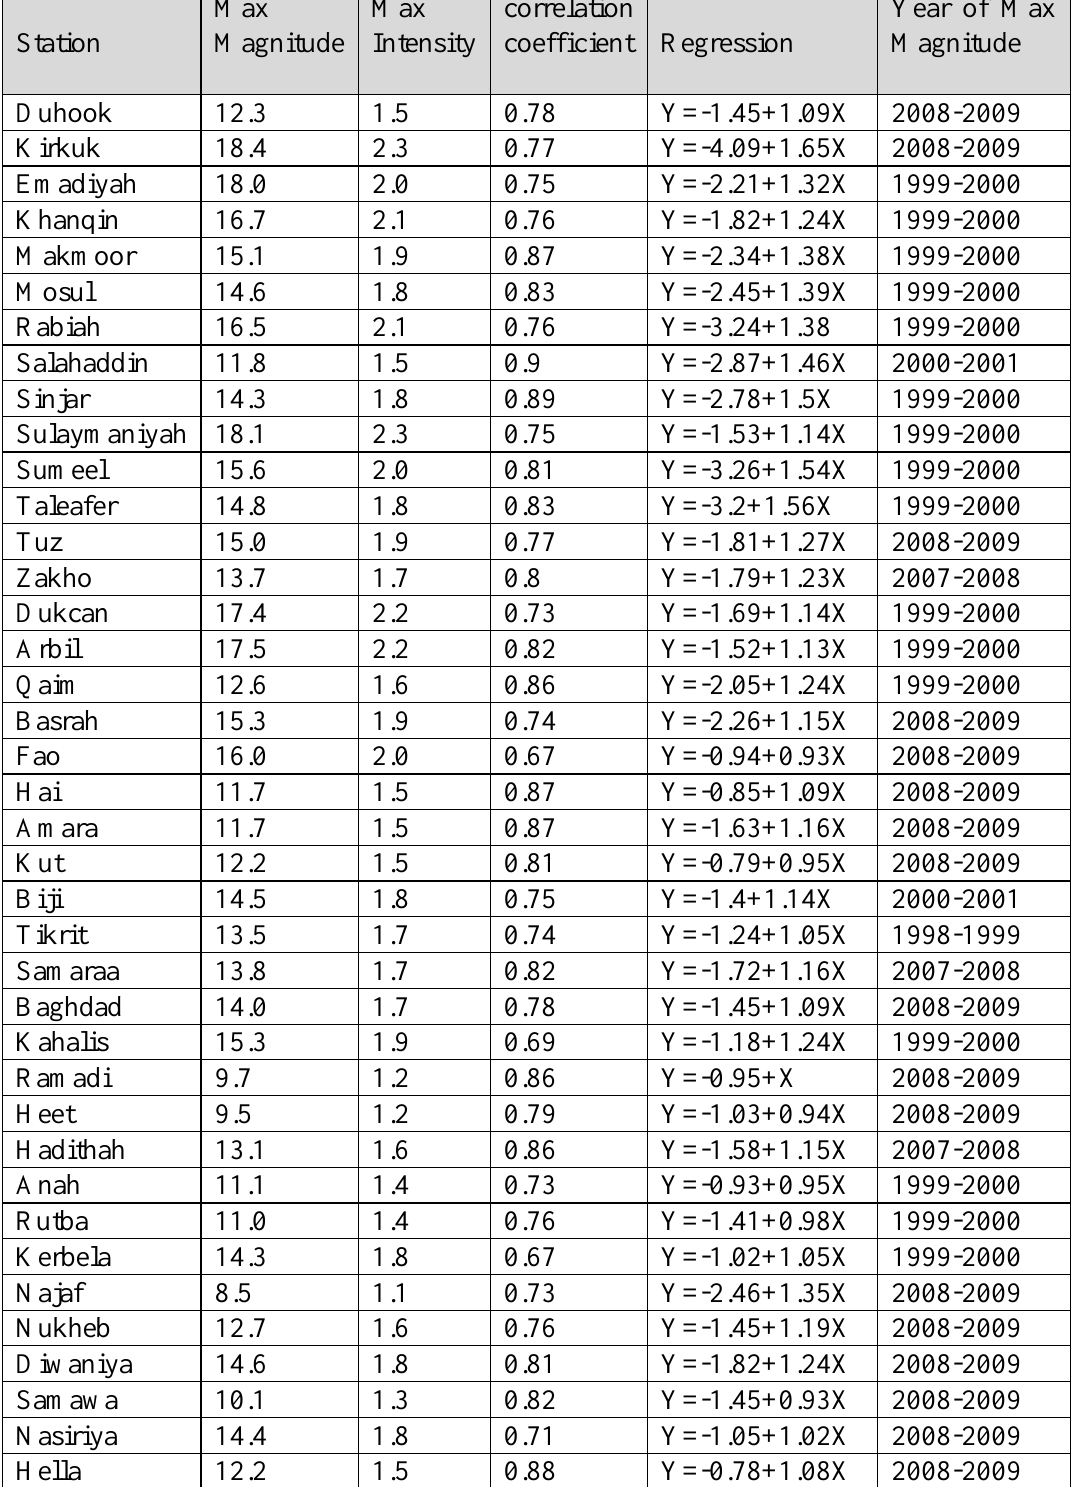
Table 3: Statistical values of drought for 39